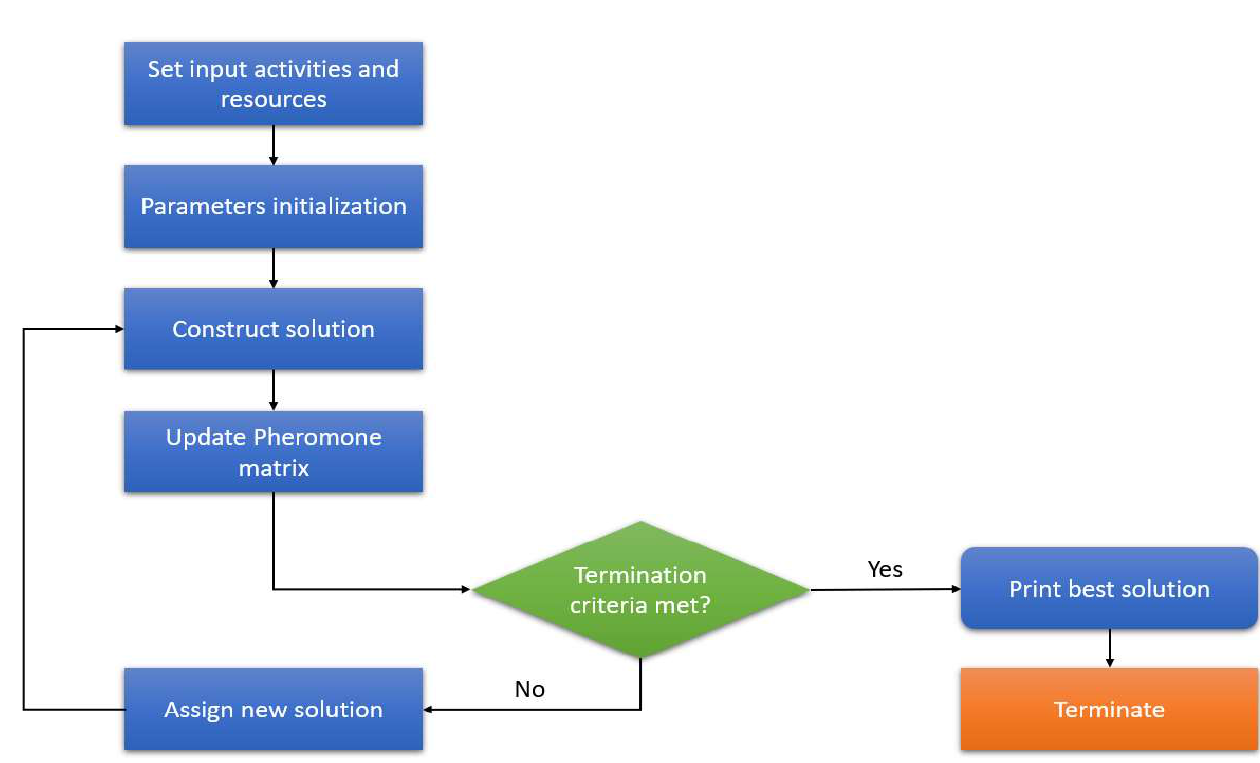
Figure 14. General flow chart for Ant Colony Optimization Algorithm.